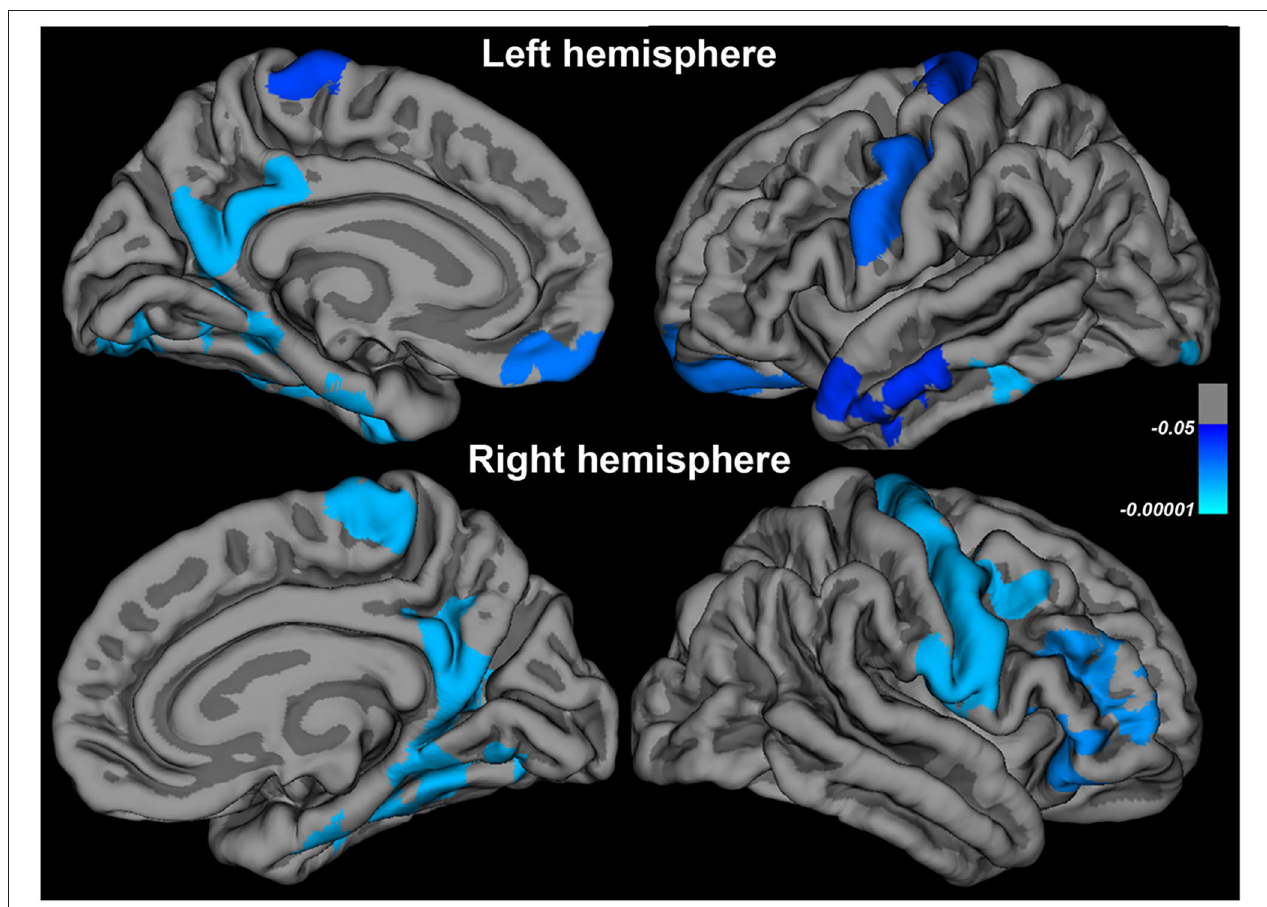
FIGURE 3 | Changes in cortical thickness in patients at follow-up compared to